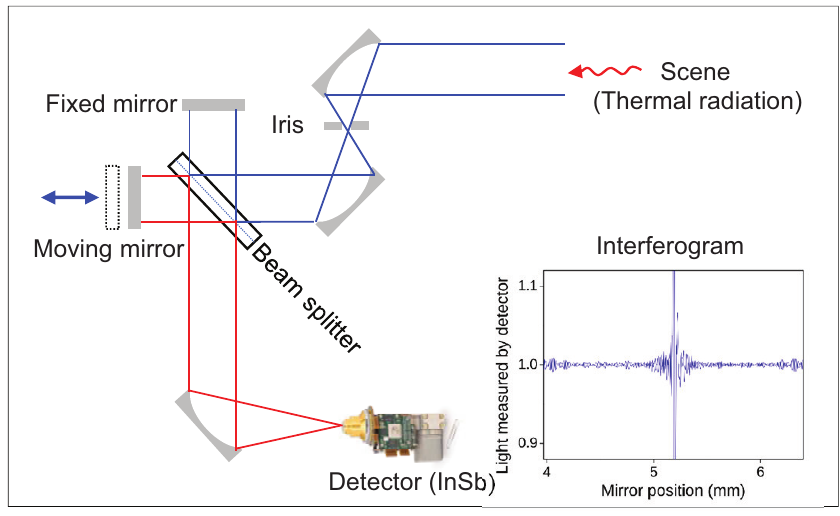
Figure 2. Basic diagram of a Michelson interferometer for passive open path